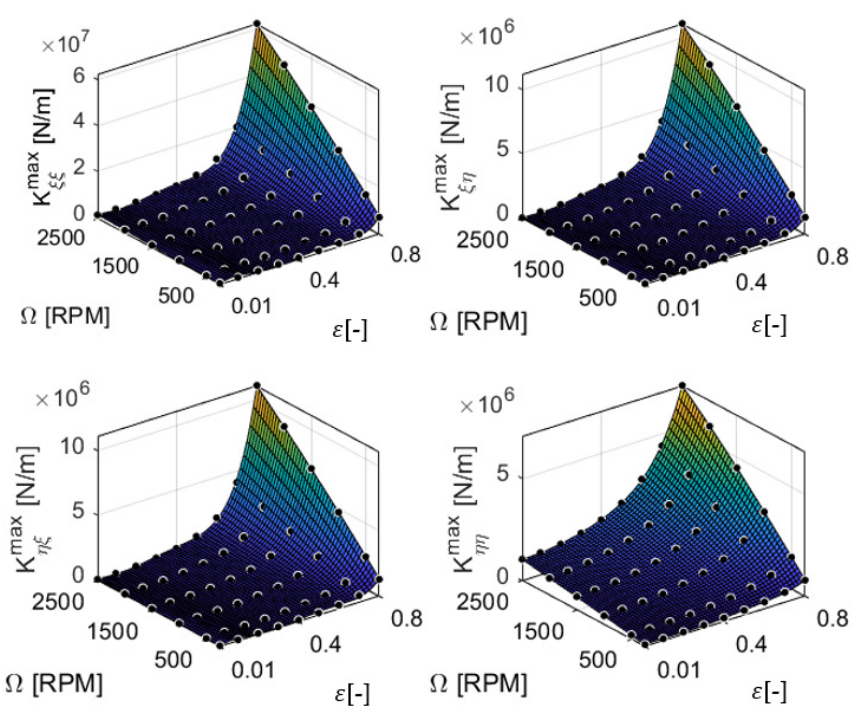
Figure 8. The maximum stiffness coefficients in the local coordinates, fitted using MATLAB ( poly53 ). The dots represent the results from the fluid film simulations.